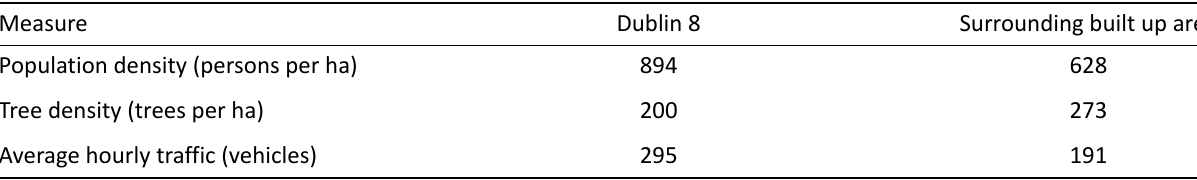
Table 2. Statistics informing neighbourhood ranking of Dublin